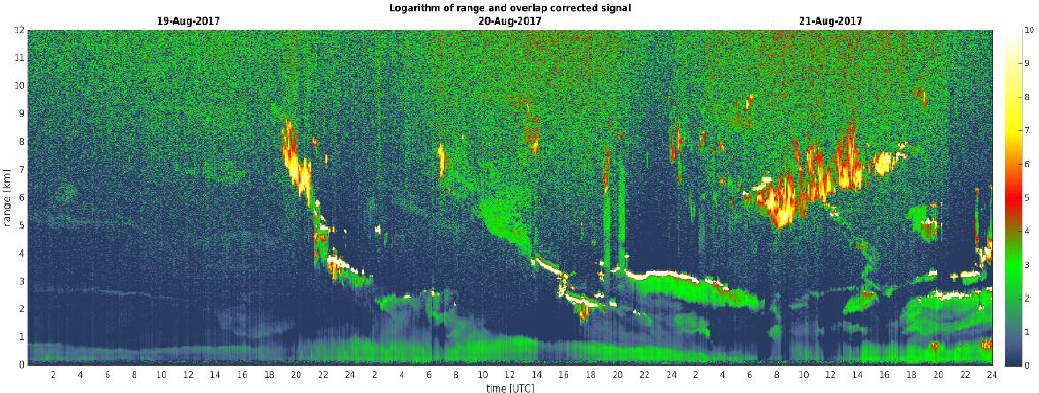
Figure 16. Logarithm of range and overlap corrected signal obtained from ceilometer measurements in Hornsund between 19 and 21 August 2017.